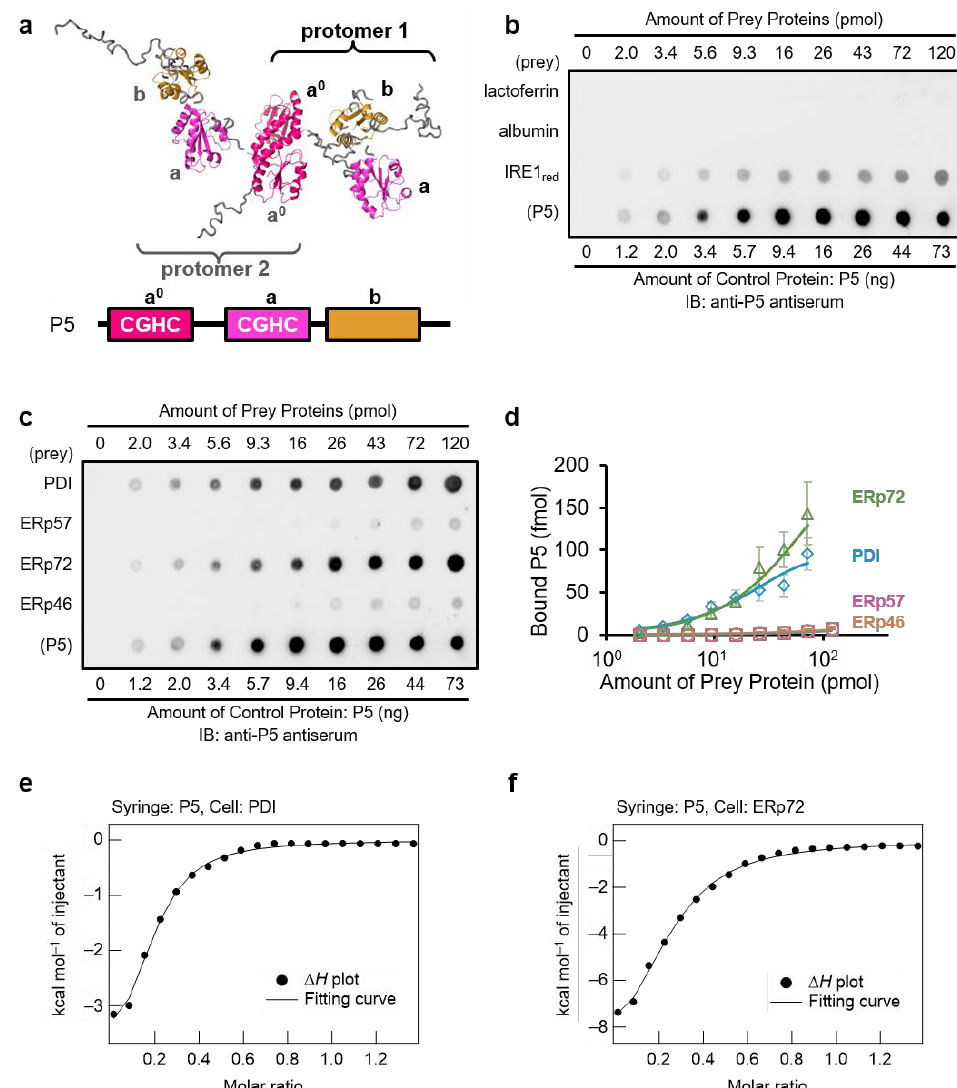
Figure 1. PDI and ERp72 are partner proteins of P5 that interact via non-covalent complex formation. ( a ) P5 structure [36]. P5 forms a dimer via the a 0 domain (the first Trx-like domain). ( b , c ) Far-western dot blot analysis of non-covalent interactions between P5 and IRE1. Prey proteins, lactoferrin, albumin (negative control), IRE1 (positive control), and PDIs were dotted onto nitrocellulose membranes. As a control, bait protein (P5) was also dotted onto the bottom lane of the same membranes. Blocked membranes were incubated in P5 bait buffer, and bound P5 was detected using anti-P5 antisera. ( d ) Quantification of chemiluminescence signals in ( c ). The amount of P5 bound to PDIs on membranes was calculated from three independent experiments, compared with the signal intensities of control dots of P5 (bottom lane). Data are presented as means ± standard error of the mean (SEM). ( e , f ) Binding isotherms for titration of P5 against PDI ( e ) and ERp72 ( f ). Catalytically-inactive P5 (Cys55/58/190/193Ala) mutant (280 µ M) in the syringe was titrated into 40 µ M PDI or 40 µ M ERp72 in the cell.